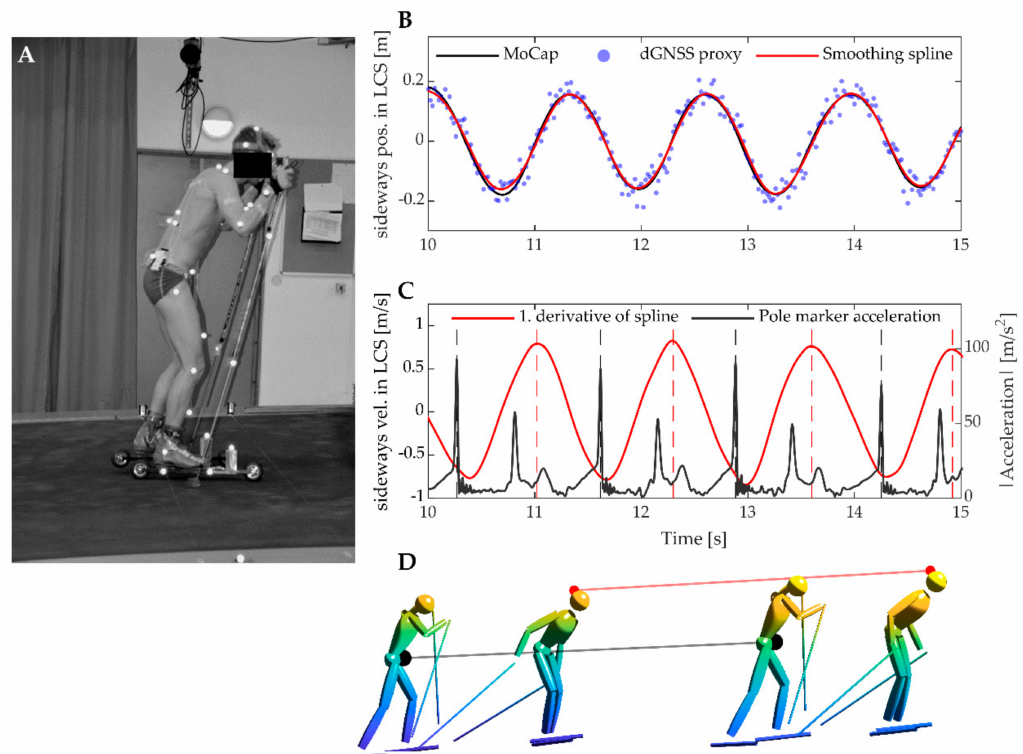
Figure 2. ( A ): Experimental setup used during the method development. A total of 41 retroreflective markers distributed on the participant’s skin and equipment were used to create a 19-segment rigid body model to estimate body center of mass (CoM) kinematics. The marker on the top of the head was used to generate a differential global navigation satellite system (dGNSS) proxy signal by downsampling to 50 Hz and adding pseudorandom white noise. ( B ): Sideways position of the dGNSS proxy (blue dots) and smoothing spline filter (red line), measured in the LCS (see manuscript body and Figure 3 for definition). ( C ): Peak sideways velocity of the dGNSS proxy signal was used to define cycle duration (dotted red lines), which was compared to cycle duration from pole ground contact (dotted black lines). ( D ): Cycle length (red line) was defined as the head’s displacement between two succeeding peaks in sideways velocity (i.e., dotted red lines in panel ( C )). This was compared to the CoM’s displacement (black line) between two successive pole plants, or every second pole plant for the G3